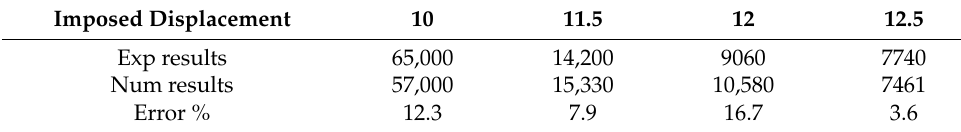
Table 7. Experimental and numerical number of cycle to failure of